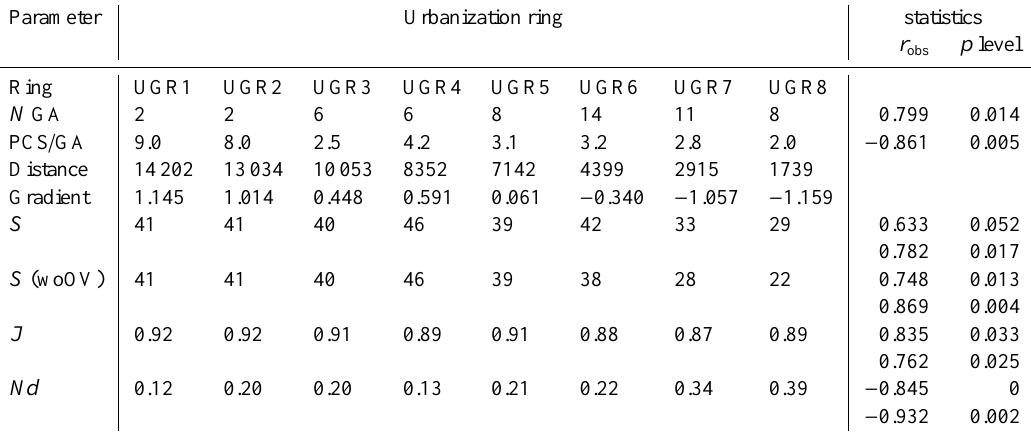
Table 6. Distribution of green areas and structural parameters of bird communities inside eight urbanization rings and correlation with the distance to the city centre and the urbanization gradient (from periphery to centre). The distance is expressed in meters. The gradient is represented by the average PCA1 scores of all local point in a given UGR; for each community parameter the r values for regression with distance (above) and gradient (below) are reported; r obs = observed r in null model regression. Abbreviations: UGR = urbanization ring; N GA = number of green areas; PCS / GA = number of point count stations per green area; S = species richness; S (woOV) = species richness without old villas; J = evenness; Nd = dominant